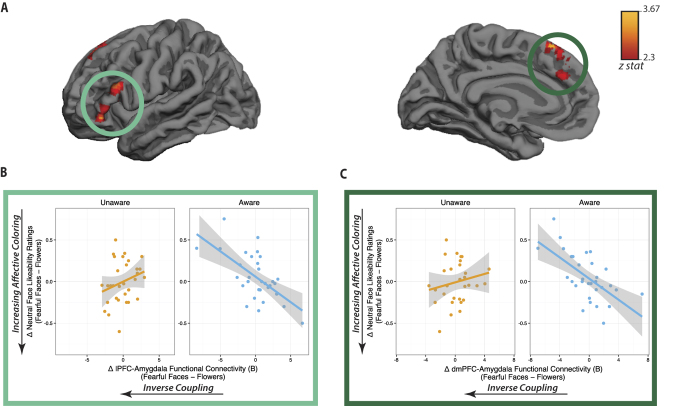
(A) During consciously aware processing of fearful faces, reduced negative bias toward novel neutral faces shown seconds later is associated with the inverse coupling between the right amygdala and left lateral and bilateral medial regions of the PFC, whole-brain corrected at Z > 2.3, p < 0.05. (B,C) Conscious awareness significantly changed the behavioral correlates of amygdala-PFC coupling, as seen by the significant difference of correlation coefficients when comparing aware vs. unaware associations between affective coloring and amygdala coupling with (B) lateral and (C) dorsomedial PFC, psslope difference < 0.05. (Note that the scatterplots are depicted here for display purposes only, to illustrate the contrast between aware and unaware conditions. See Table 3 for the results of an unbiased, whole-brain corrected examination of the impact of awareness on these associations).